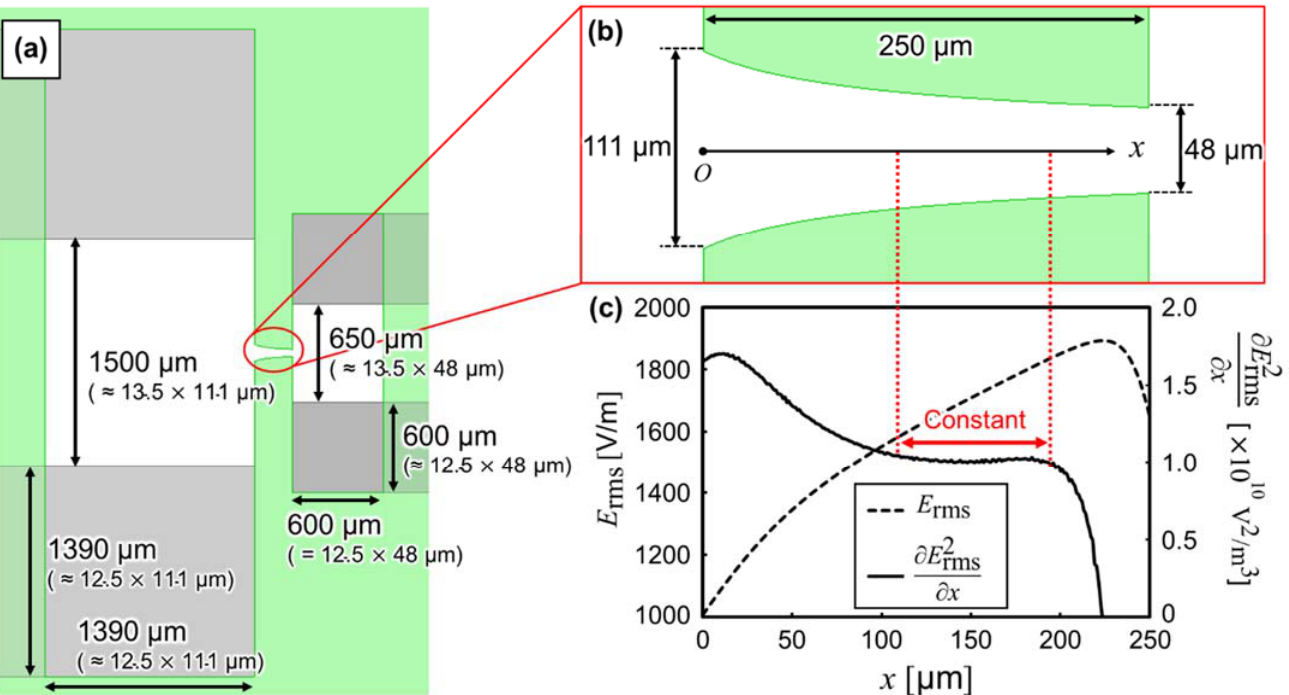
Figure 4. ( a ) Top view of the designed electrode shape of isomotive iDEP creek-gap device. ( b ) Top view of the designed shape of the creek-gap insulators. ( c ) Distribution of the magnitude of electric field, E rms , and ∂ E 2 rms / ∂ x on the centerline of the creek-gap insulators. ∂ E 2 rms / ∂ x was approximately constant within ±2.5%, in the range of x = 110 µm to 195 µm.